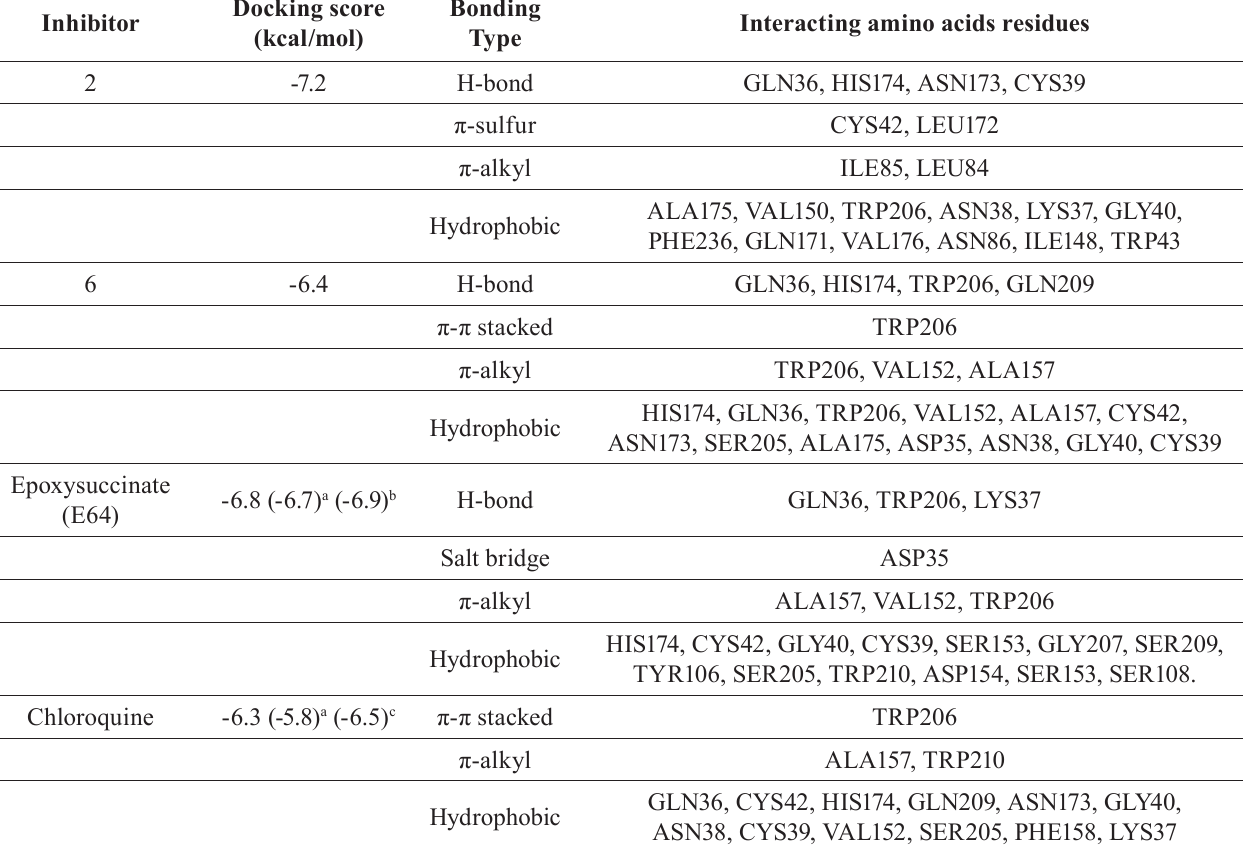
TABLE III - Best binding energy (kcal/mol) based on AutoDock scoring of the hybrids into the active sites of the protozoal